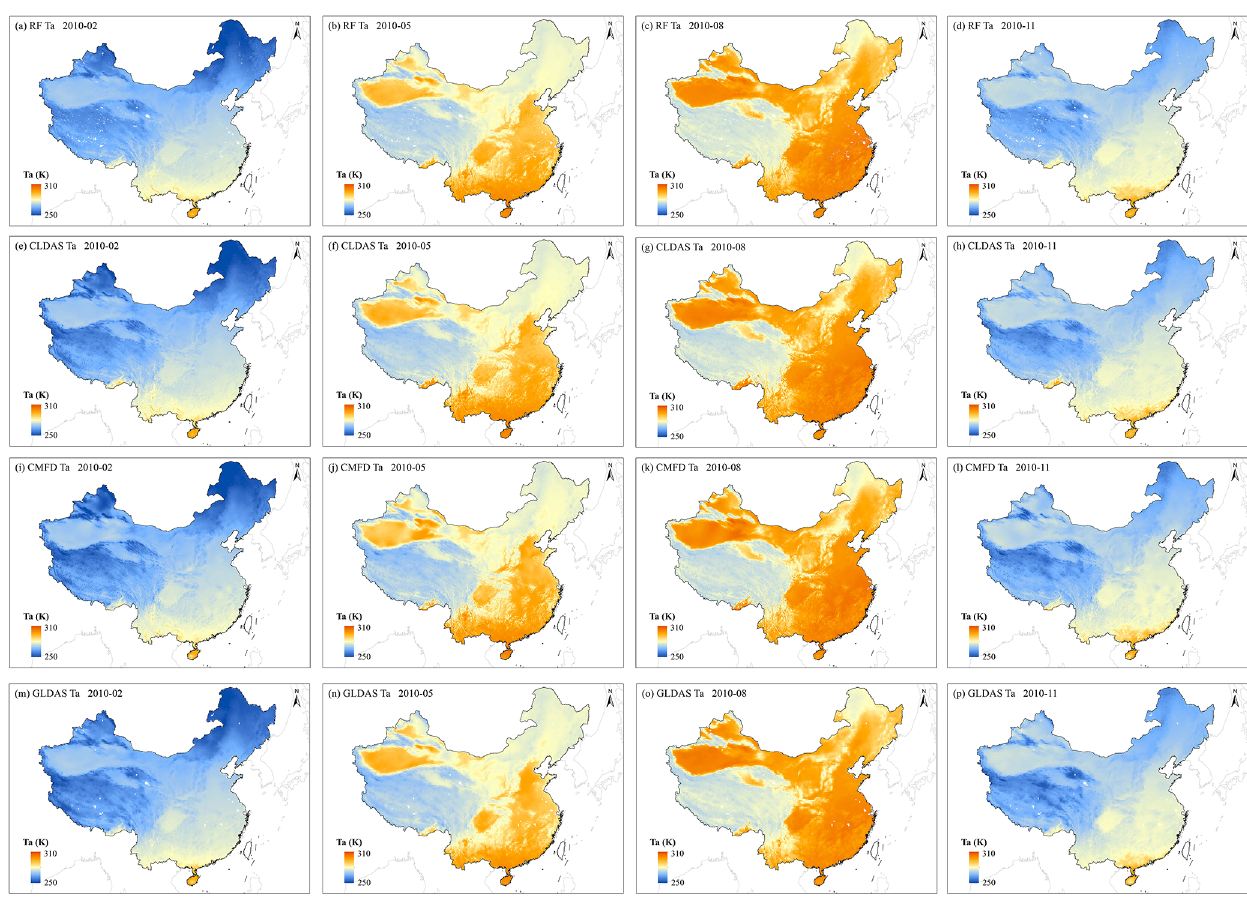
Figure 14. Maps of monthly mean T a over mainland China. Panels (a) – (d) show the the RF T a , panels (e) – (h) show the CLDAS T a , panels (i) – (l) show the CMFD T a , and panels (m) – (p) show the GLDAS T a in February, May, August, and November 2010, respectively. The white pixels in mainland China indicate no data value and are always water